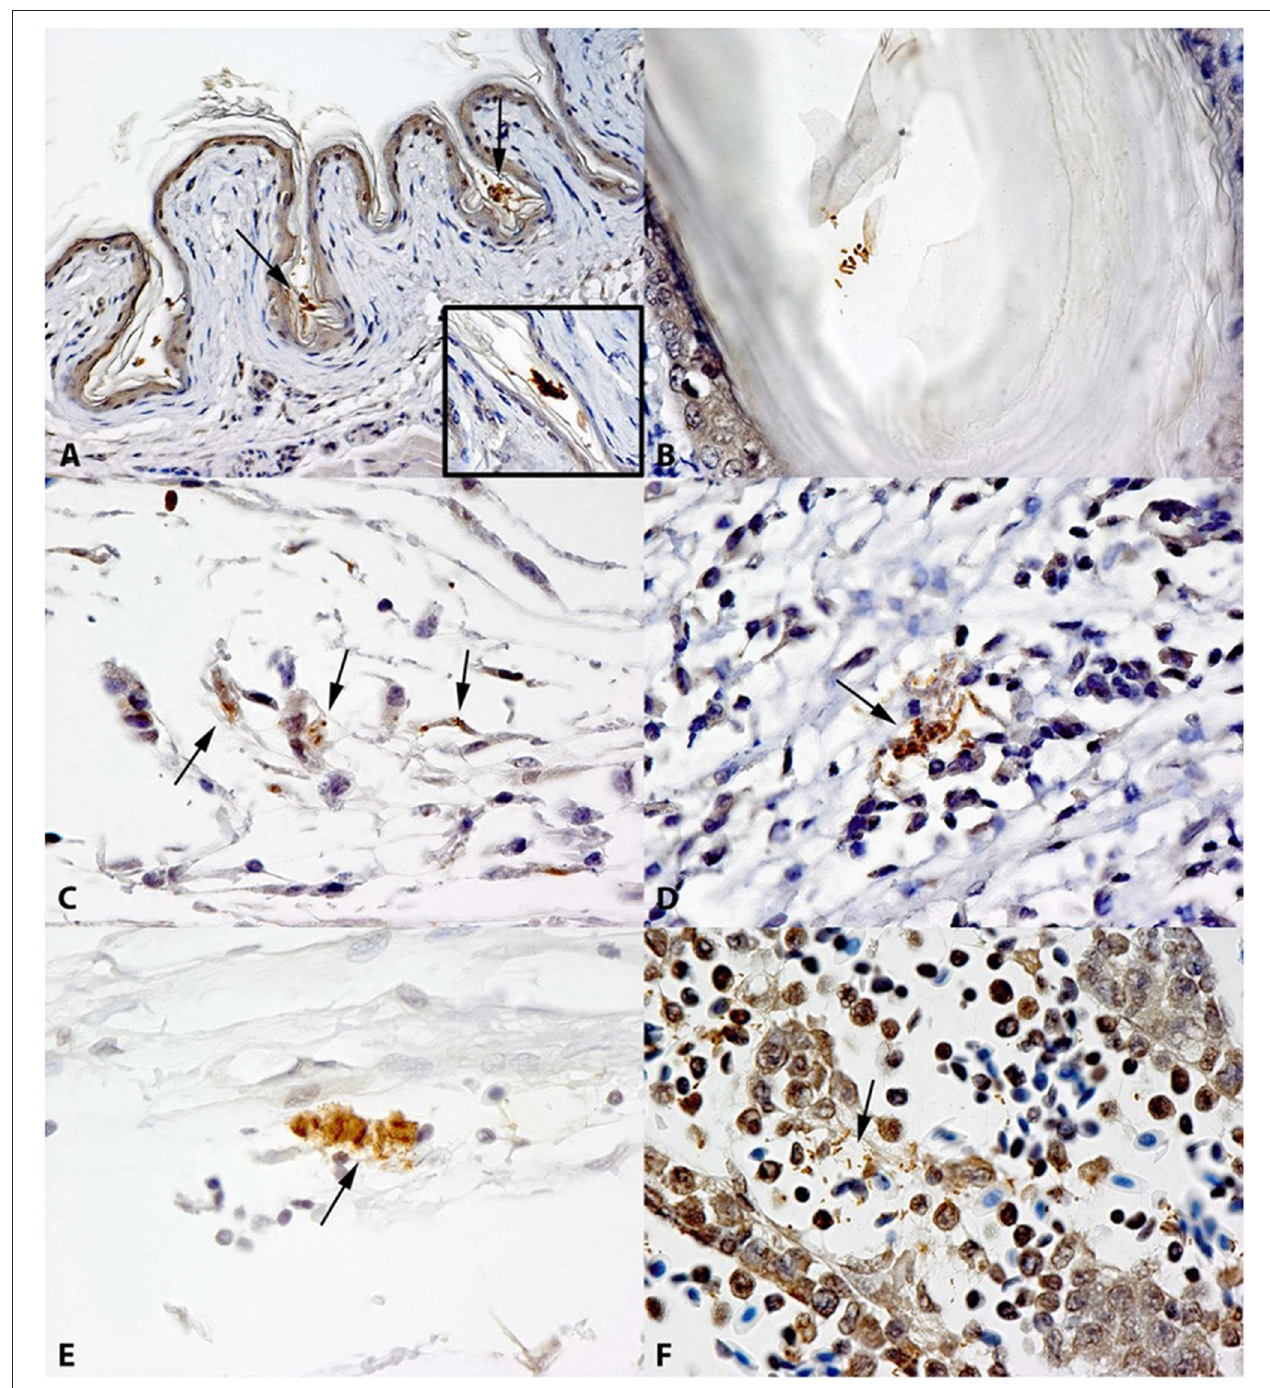
FIGURE 2 | Immunohistochemical localization of Salmonella in tissues of experimentally infected chickens. (A) Clusters of Salmonella O serogroup B-positive bacteria on epidermal keratin (arrows) in a chicken infected with S . Heidelberg 380- lux . (B) Salmonella O serogroup B-positive bacteria on the stratum corneum of the feather follicle in a chicken infected with S . Heidelberg 380- lux . (C) Salmonella O serogroup B-positive bacteria in the cytoplasm of cells resembling fibroblasts (arrows) in the muscle from a chicken infected with S . Typhimurium SL1344- lux . (D) Salmonella O serogroup B-positive bacteria in the lumen of a lymphatic vessel (arrow) in the muscle of a chicken infected with S . Typhimurium SL1344- lux . (E) Salmonella O serogroup B-positive bacteria in the cytoplasm of cells resembling monocytes (arrow) in lymphatic vessel in the muscle of a chicken infected with S . Heidelberg 380- lux . (F) Salmonella O serogroup B-positive bacteria in the bone marrow (arrow) in a chicken infected with S . Typhimurium SL1344- lux